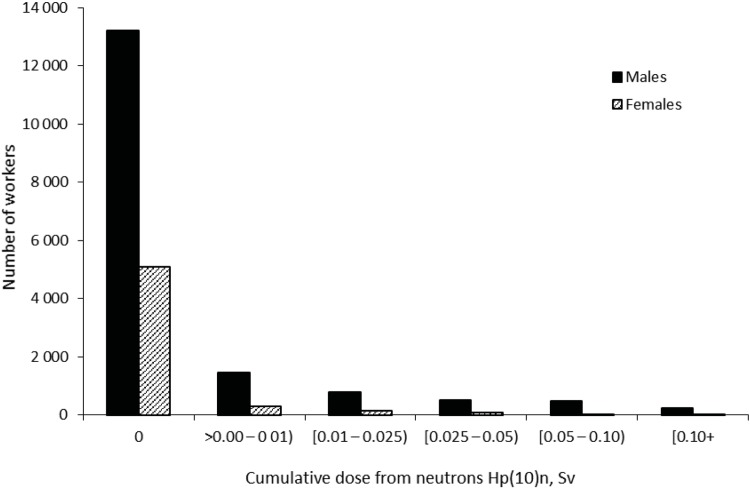
Distributions of workers from the study cohort depending on cumulative dose from neutrons.